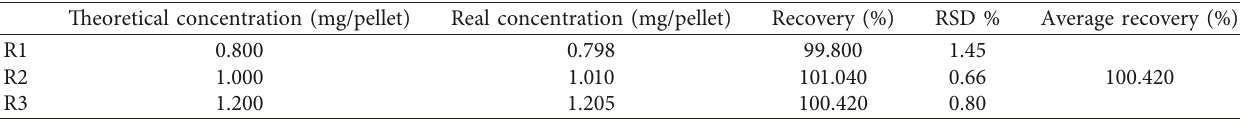
Table 3: Accuracy of the spectrophotometric method in the mid-infrared region for analysis of amoxicillin capsules. Theoretical concentration (mg/pellet)